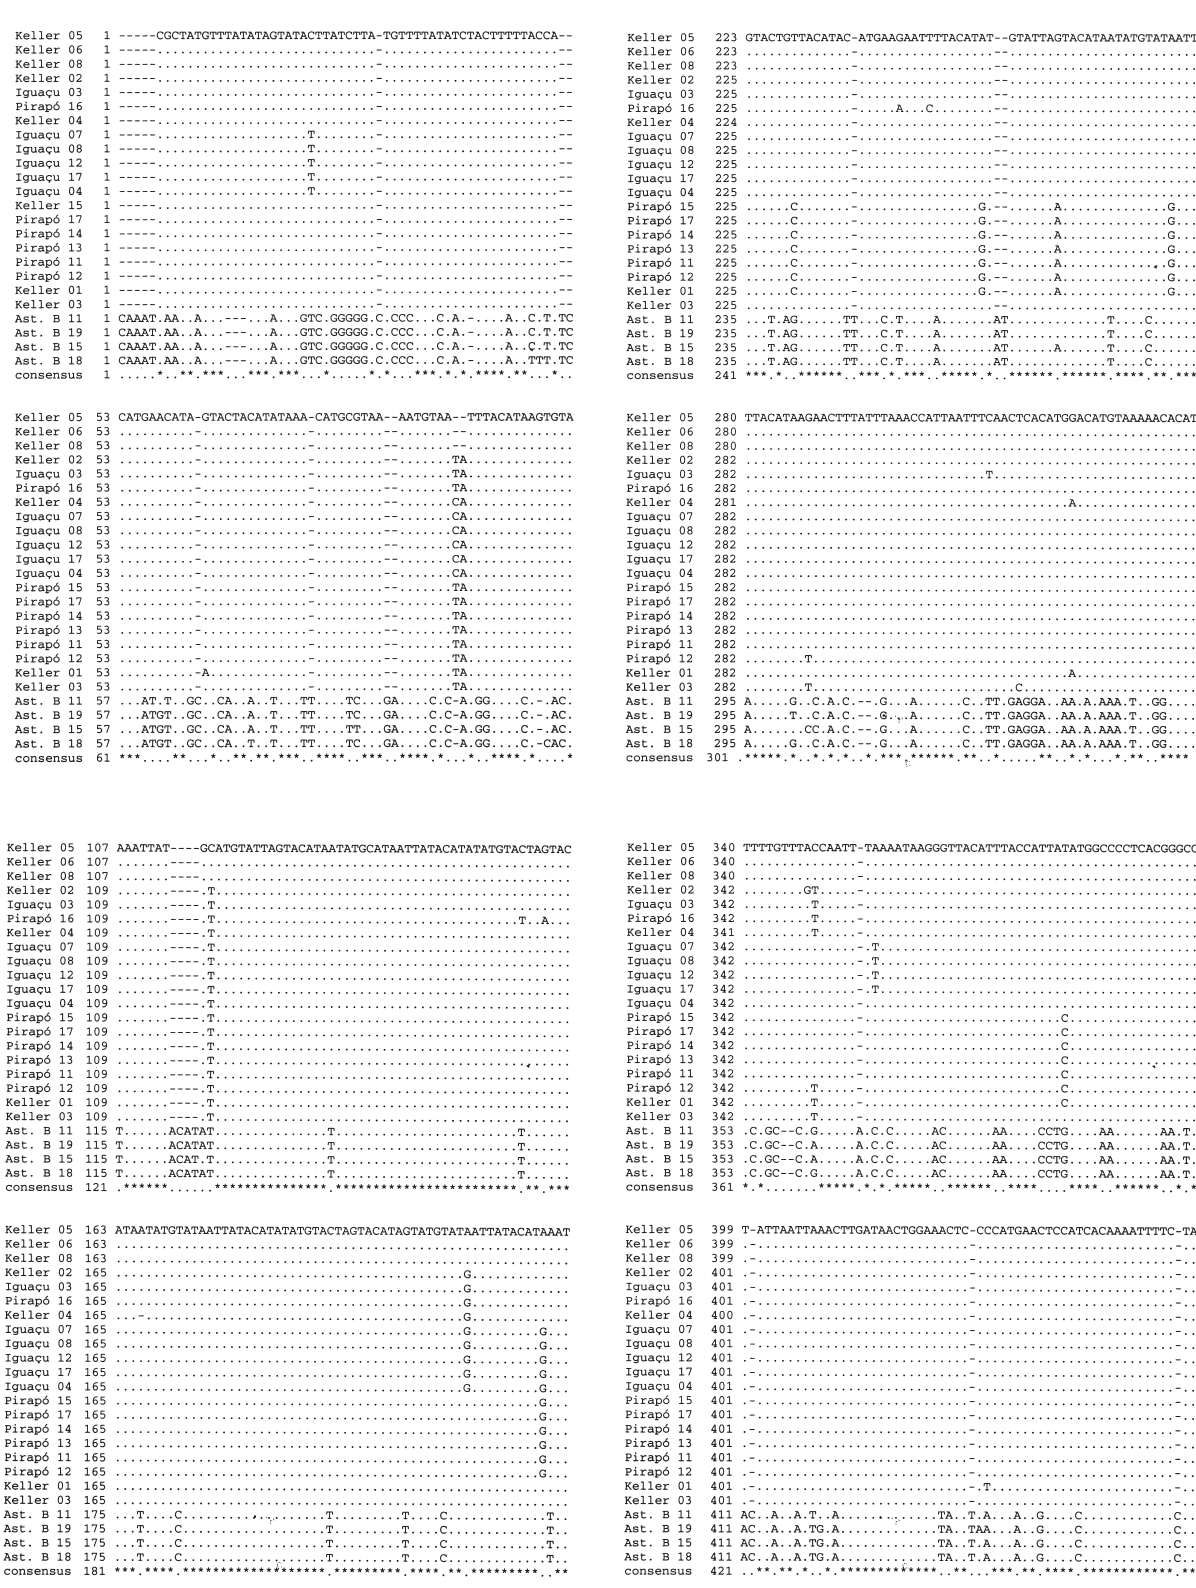
Figure 1 - Multialignment on Clustal W of nucleotide sequences from the mitochondrial control region of Astyanax altiparanae specimens from the Iguaçu River and from the Keller and Pirapó tributaries of the Upper Paraná River basin, and specimens of the closely related species Astyanax sp B from Iguaçu